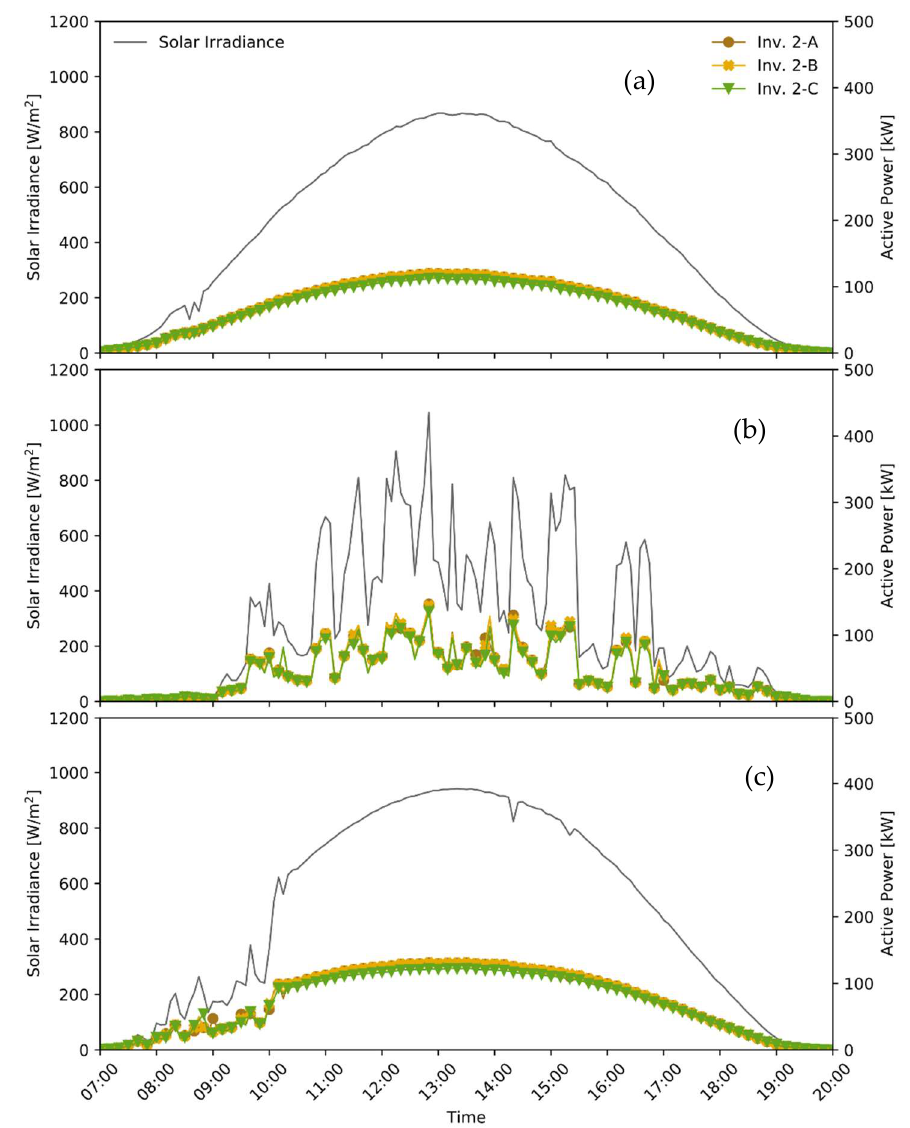
Figure 3. Analysis of sensor signals of the Inverter 2 on 30st August ( a ), on 31th August ( b ) and on 1st September ( c )—Solar Irradiance over the Active Power of the inverter blocks.